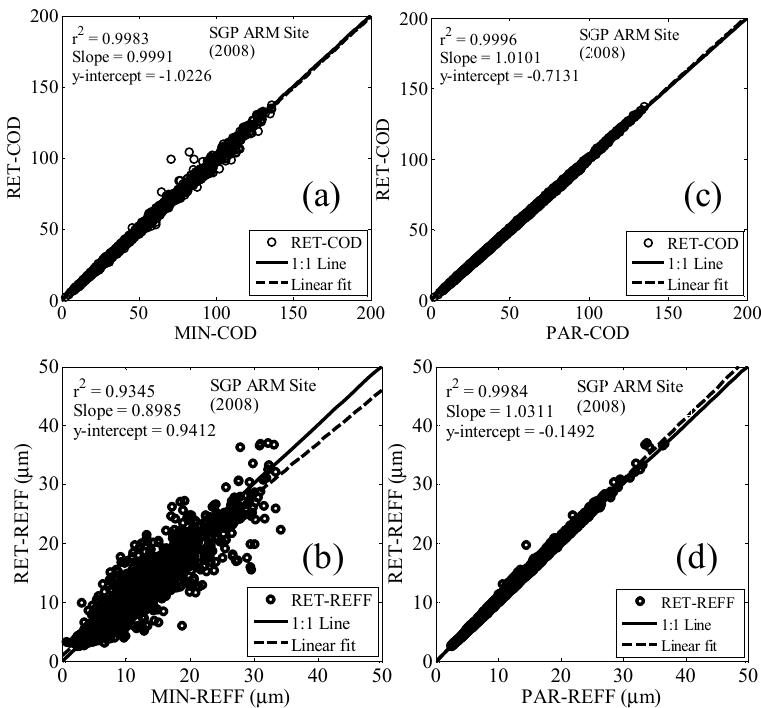
Figure 7. Scatter plot between retrieved instantaneous COD and REFF using RET approach compared to those of MIN ( a , b ) and PAR ( c , d )